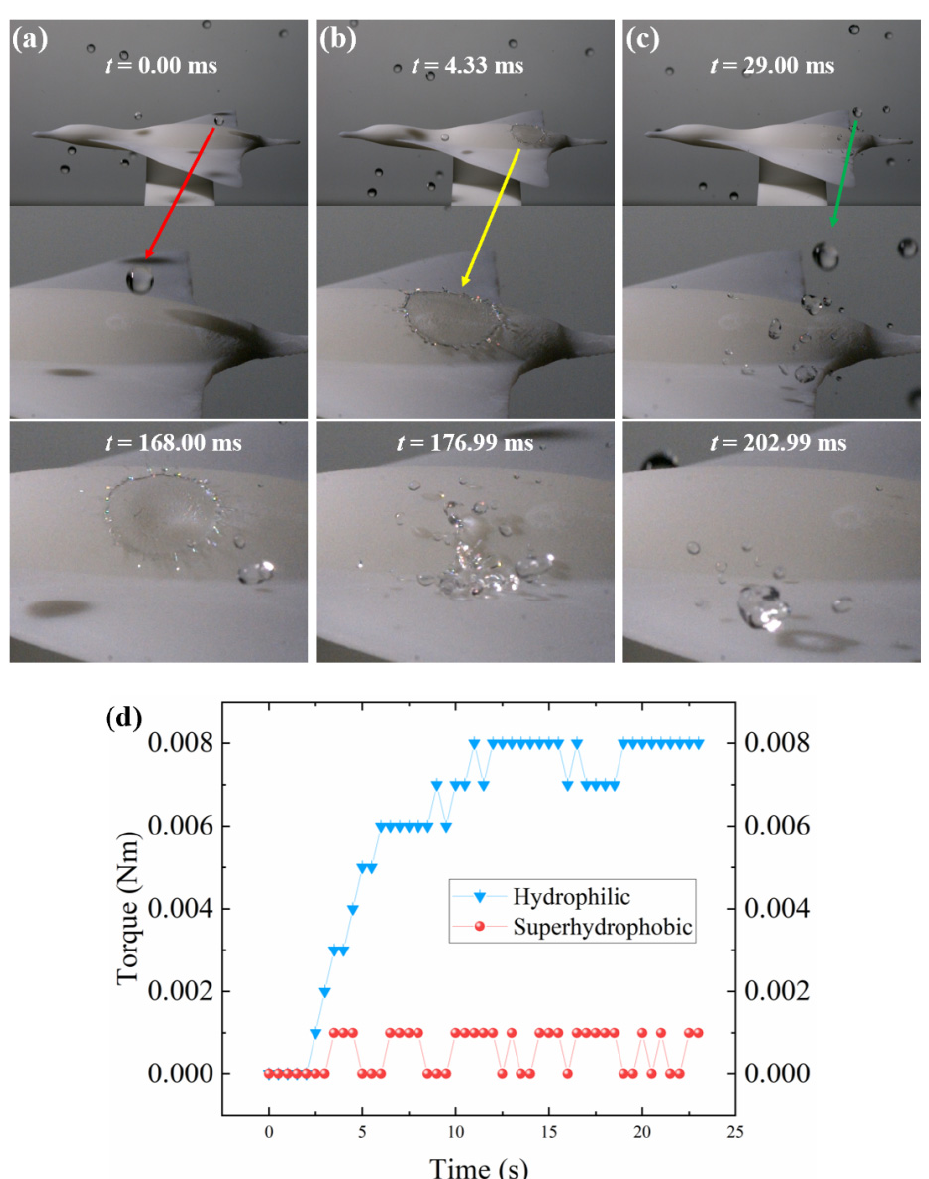
Figure 4. Multiple droplets hit a stationary superhydrophobic model; the graph shows the impact- level analysis. As indicated from ( a – c ), the impinging droplets break up and bounce off, and the superhydrophobic surface remains dry. ( d ) The superhydrophobic surface significantly weakens the impact force (qualitatively equivalent to torque), and the peak torque is only 1/8 of that of hydrophilic surfaces (see details in “Supporting Movie S2” in the Supplementary